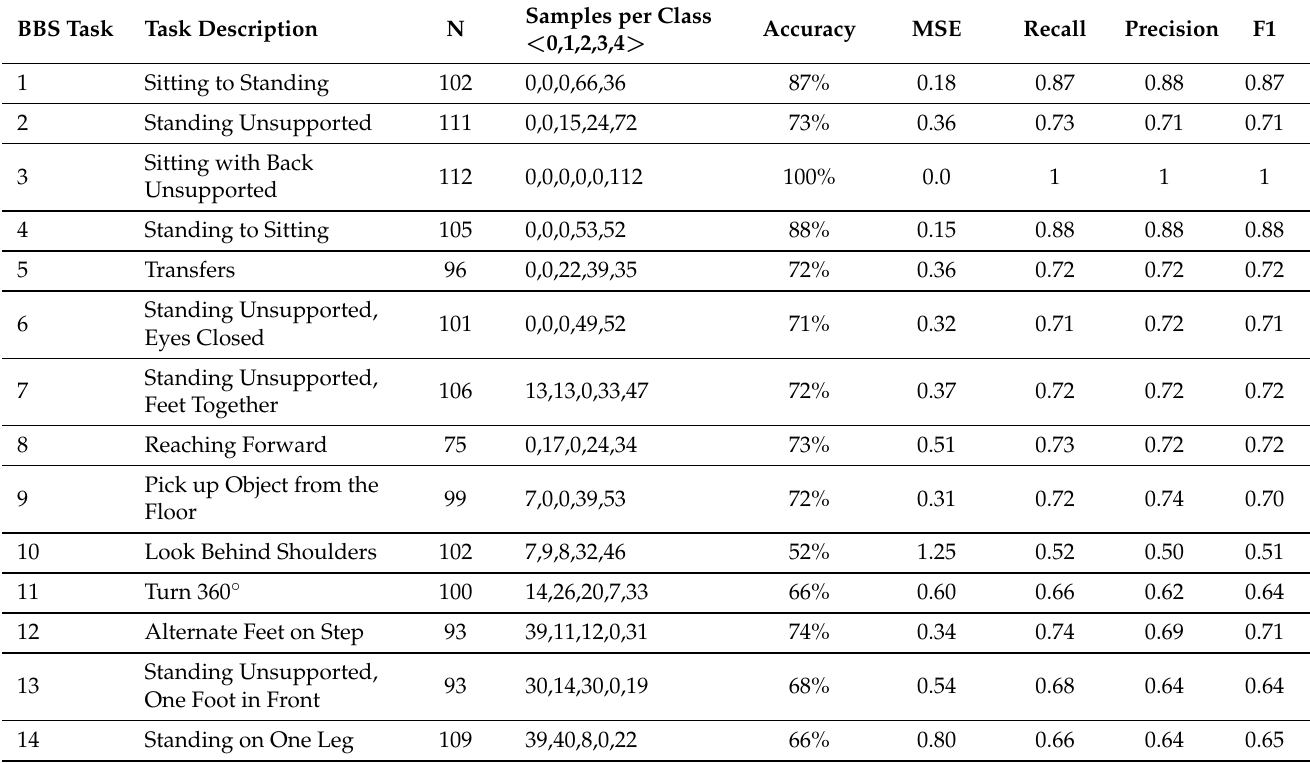
Table 1. Automatic prediction of BBS scores per